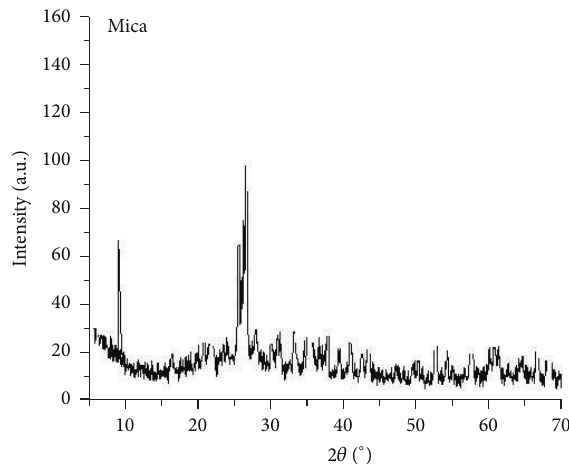
Figure 2: Diffractogram of the micronized mica sample, series M 4 .